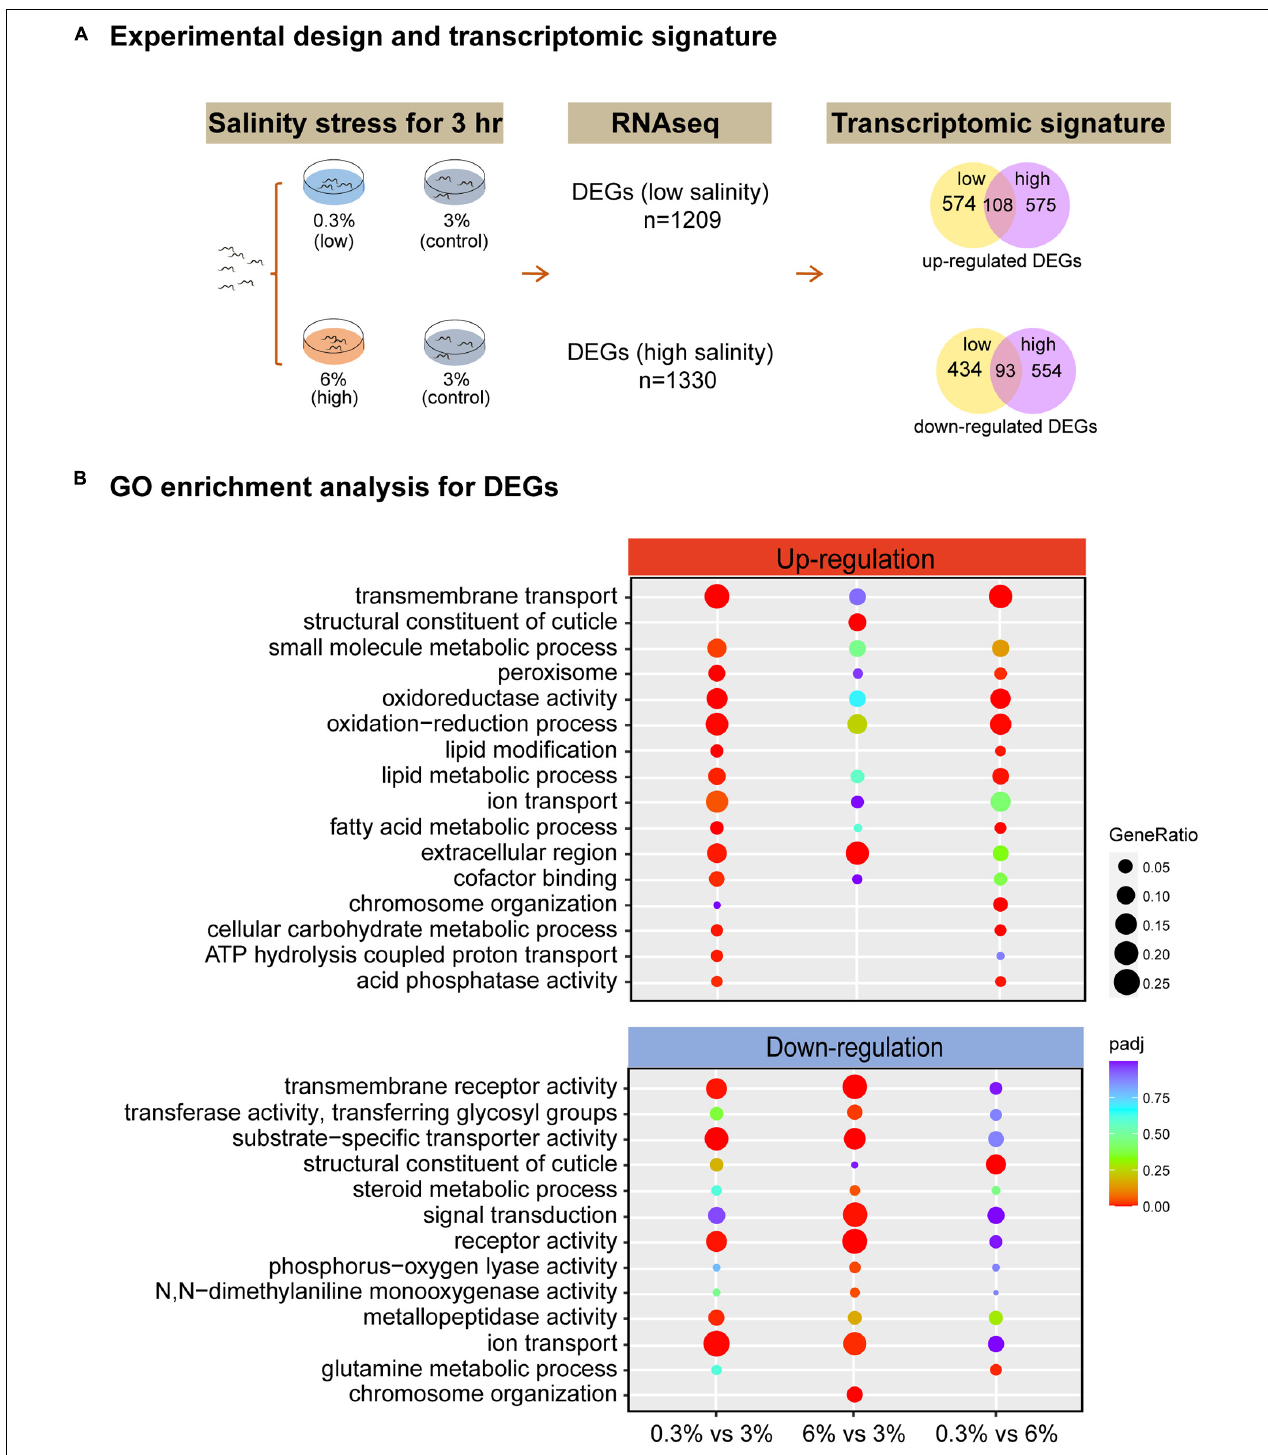
FIGURE 2 | RNA-seq identifies the transcriptomic signature of short-time salinity stressed marine nematodes. (A) Experimental design of this study and the resulting transcriptomic signature of salinity stressed worms. Differentially expressed genes (DEGs, | log2foldchange| > 1; DESeq2 padj < 0.05) were determined for each condition. (B) GO enrichment analysis for DEGs. | log2foldchange| > 1; DESeq2 padj < 0.05 was set as the differential gene screening threshold. GO enrichment analysis of DEGs were achieved by clusterProfiler R package (v3.4.4), an adjusted P -value (padj) < 0.05 was considered significantly enriched. The color from red to purple represents the significance of the enrichment. GeneRatio was defined as the ratio of the number of differential genes annotated to the GO term to the total number of differential genes.